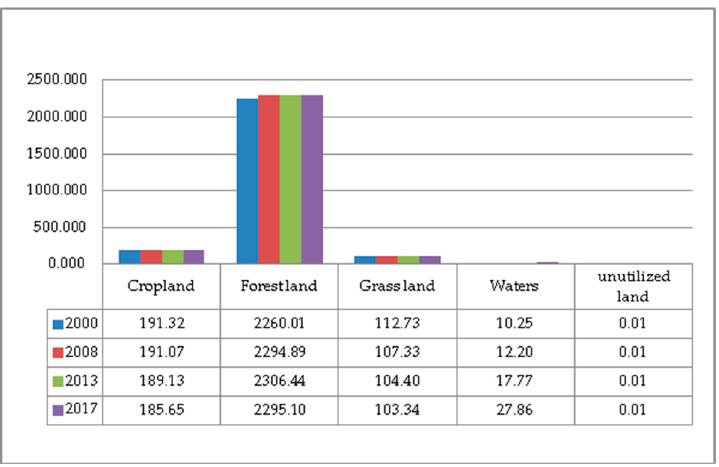
Figure 16. The ESV of various land cover types.